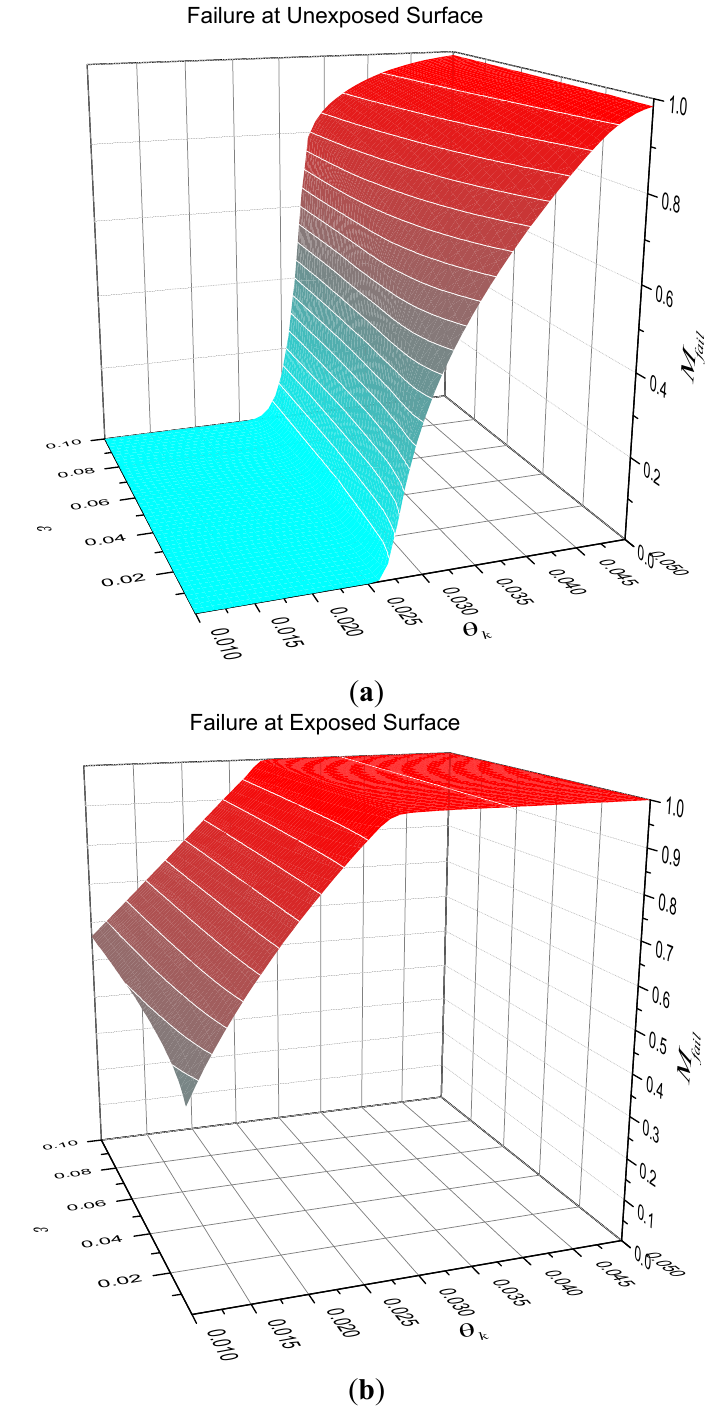
Figure 6. Mass fraction of heat sink at failure at G = 0.05. ( a ) contour plot; ( b ) surface